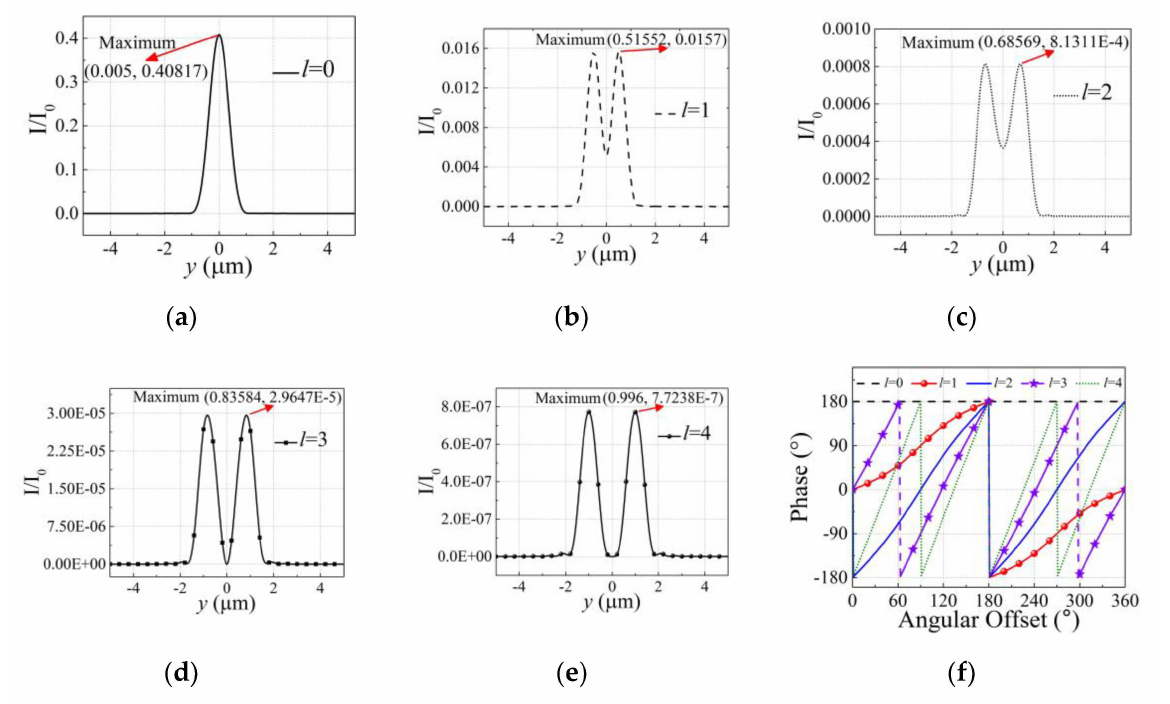
Figure 3. ( a – e ) show the one-dimensional intensity distribution of the incident beams with differ- ent topological charges in the polarization direction; ( f ) shows the phase sampling results along the